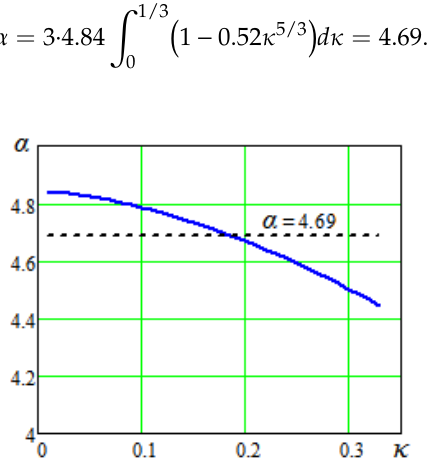
Figure 4. The dependence of the contact area ratio on the variation coefficient for the normal distribution law.